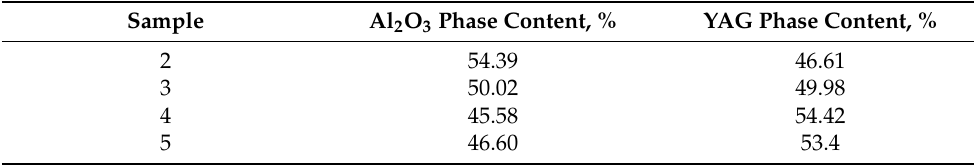
Table 2. The sapphire and garnet phase proportions of the eutectic